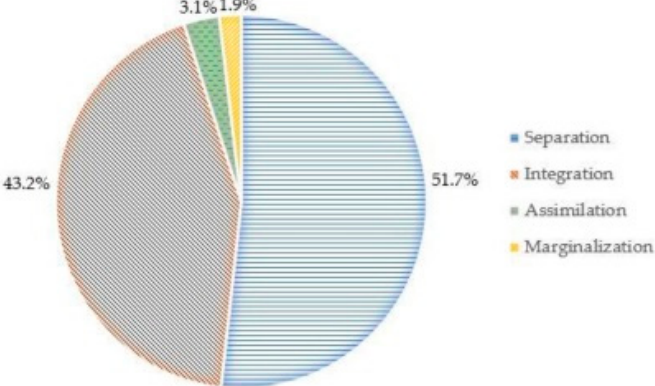
Figure 1. Acculturation strategies of the study participants, Myanmar migrant workers, in Chiang Mai, Thailand, 2017, ( n = 414).